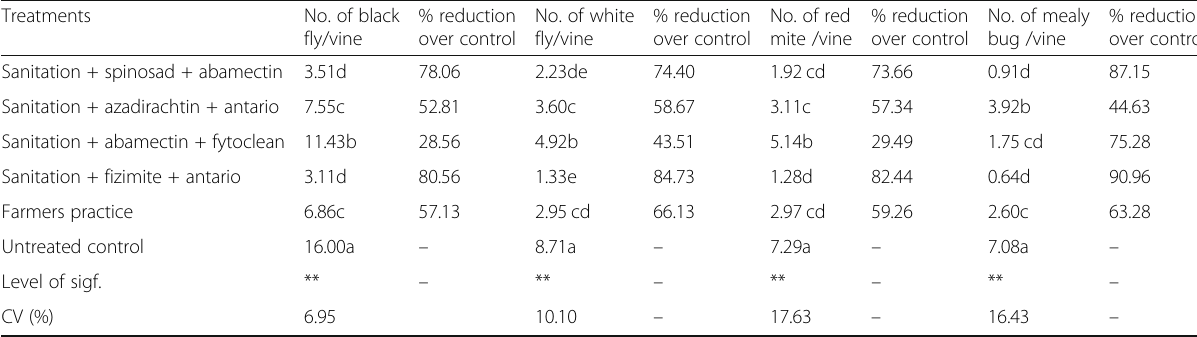
% reduction No. of white % reduction No. of red % reduction No. of mealy % reduction fly/vine over control fly/vine over control mite /vine over control bug /vine over control